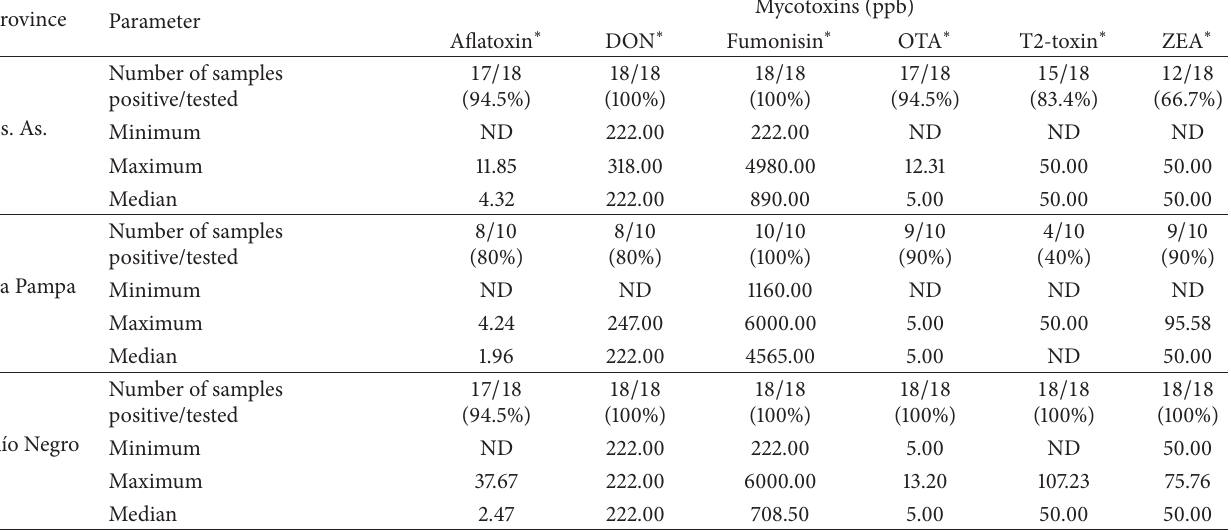
Table 4: Concentration of different mycotoxins in poultry feed samples (ND: not detected).